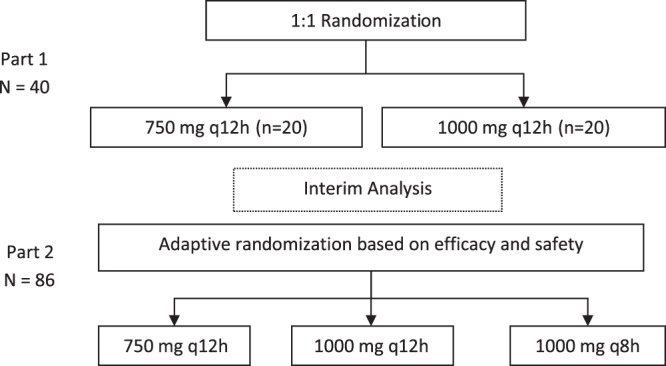
Study design. In both part 1 and part 2, at the discretion of the investigator, patients who completed the minimum intravenous dosing duration could be switched to a corresponding unblinded oral dosing regimen (1,500 mg or 2,000 mg twice a day, or 2,000 mg three times a day for part 2) in an outpatient setting to complete 10 days of total treatment. Part 2 was expected to enroll approximately 80 patients by use of an adaptive randomization strategy. A total of 86 patients were enrolled in part 2. Each of the preidentified doses for part 2 were used based on the outcomes of the analyses from part 1. The maximum dose was not to exceed a total daily dose of 4.5 g/day given intravenously or 6.0 g/day given orally.